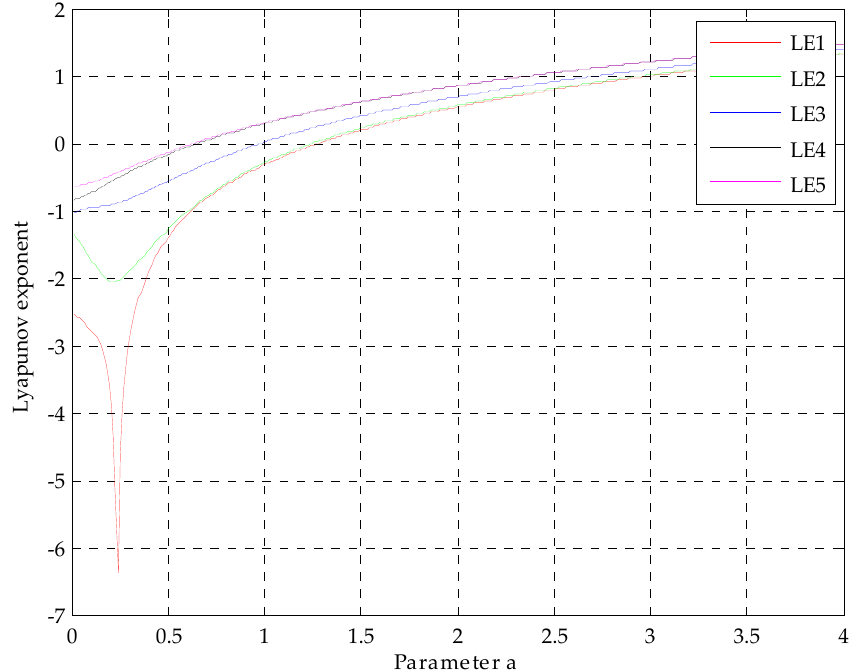
Figure 6. Exponential Lyapunov spectrum of the five-dimensional system (2).